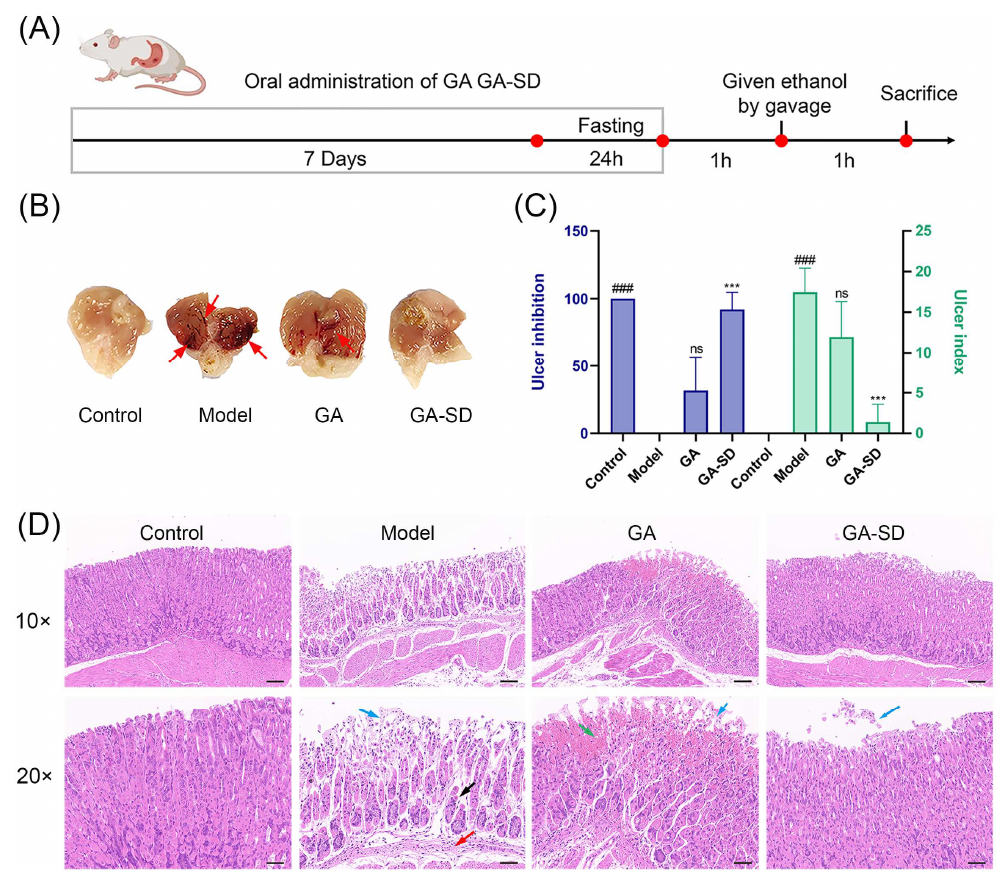
Figure 11. Effect of GA-SD on ethanol-induced gastric ulcer in mice. ( A ) Experimental protocol. ( B ) Macroscopic appearance of gastric tissues ( C ) Ulcer index and the inhibition rate. Data are presented as the mean ± SD ( n = 3). Different letters indicate statistically significant differences at the level of p < 0.05. ### p < 0.001 when compared with the control group; *** p < 0.001 when compared with the model group. ( D ) H&E staining of gastric tissues (magnification of 10× and 20×). Scale bar of 10×: 100 µm. Scale bar of 20×: 50 µm. Green arrow: hemorrhagic injury; blue arrow: loss of gastric epithelial cells; red arrow: inflammatory cells infiltration; black arrow: disorganized glandular structure.